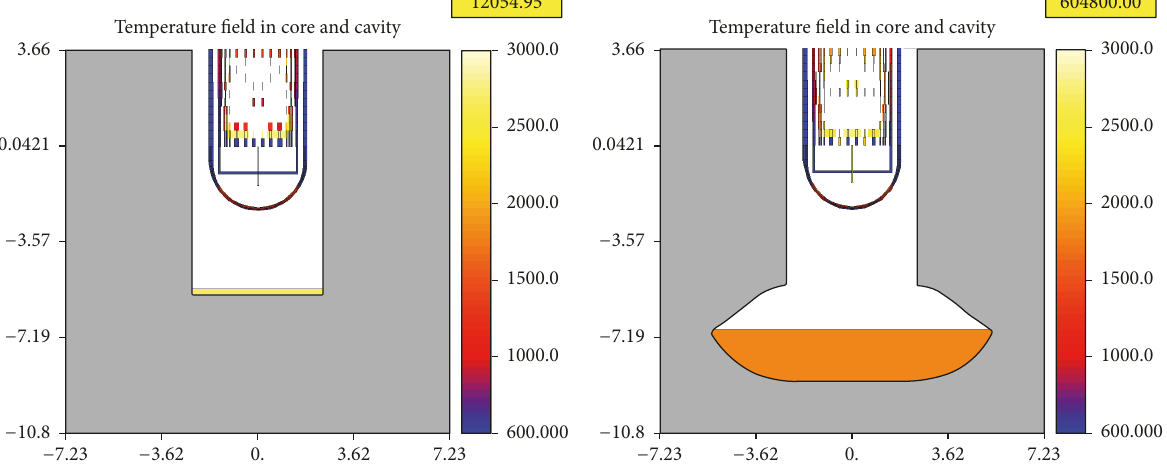
Figure 14: Initial and final cavity temperature profiles as calculated by the ASTEC code.